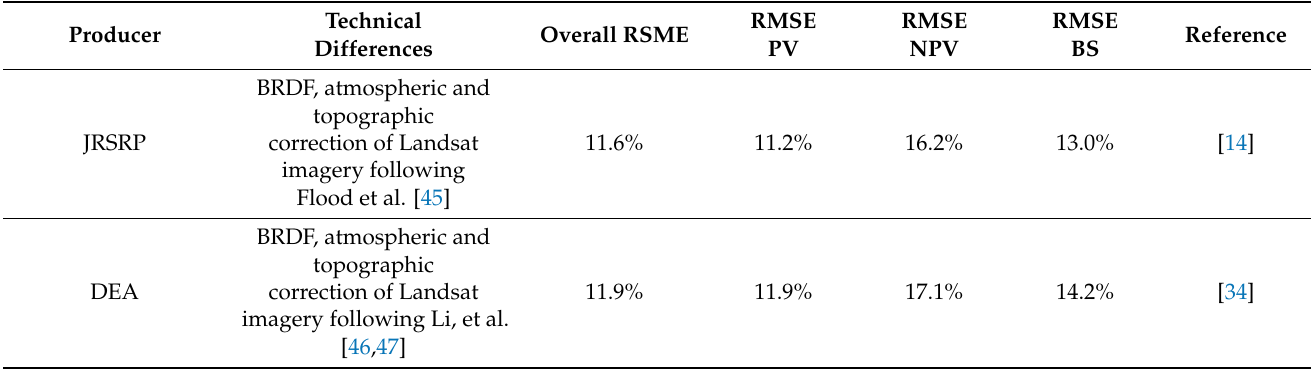
Table 1. Published validation results for Joint Remote Sensing Research Program’s (JRSRP) and Digital Earth Australia’s (DEA) vegetation fractional cover algorithms. (BRDF: bidirectional reflectance distribution function, RMSE: root mean square error, PV: photosynthetic vegetation, NPV: non- photosynthetic vegetation, BS: bare